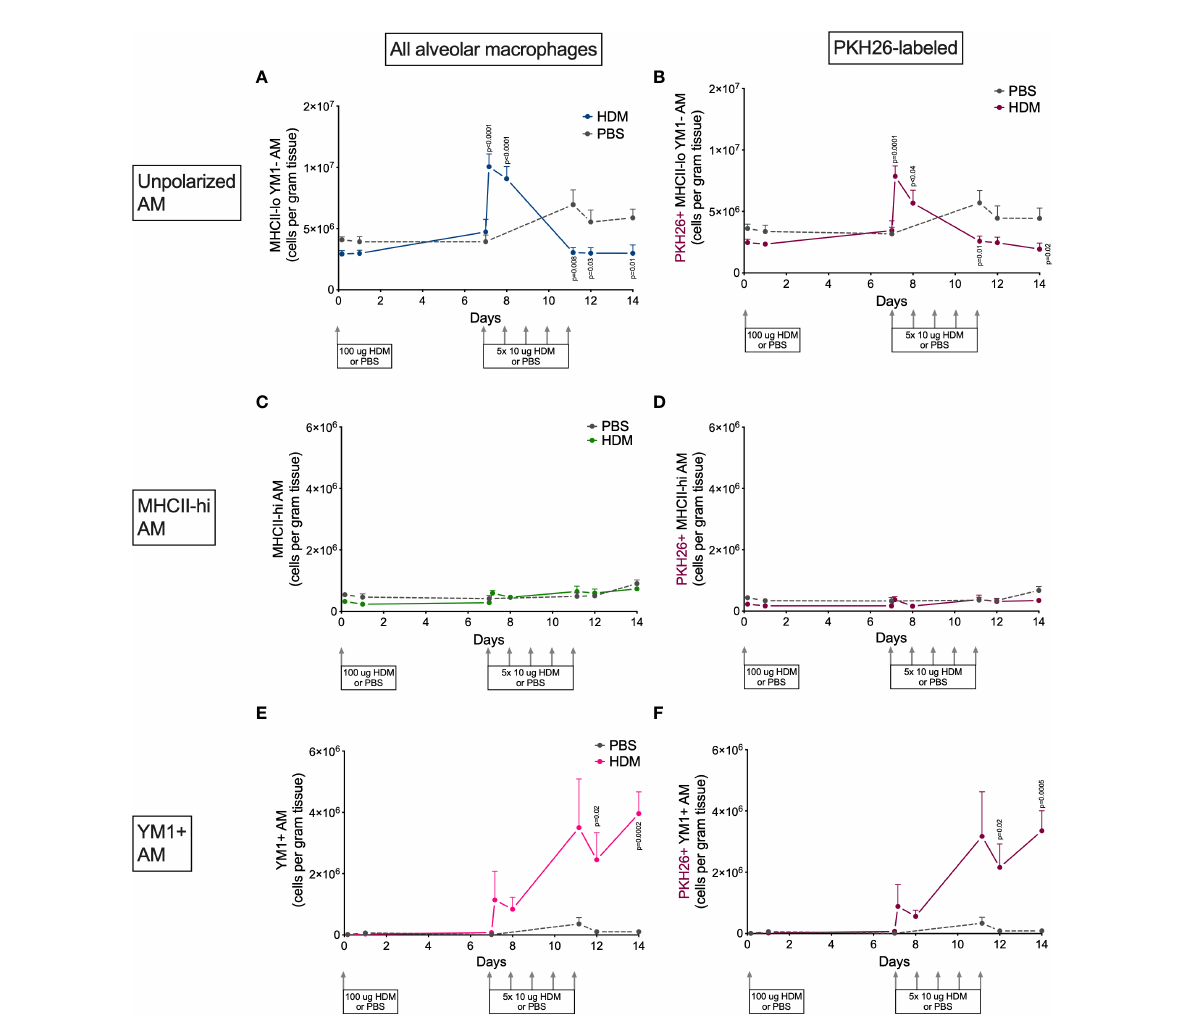
FIGURE 6 Numbers of (A) MHCII-loYM1- alveolar macrophages, (B) PKH26+MHCII-loYM1-alveolar macrophages, (C) MHCII-hi alveolar macrophages, (D) PKH26+MHCII-hi alveolar macrophages, E) YM1+ alveolar macrophages, (F) and PKH26+YM1+ alveolar macrophages in lung tissue of house dust mite (HDM)-exposed and phosphate-buffered saline (PBS)-exposed mice at different time points during exposure. The differences between HDM and PBS per time point were tested using a Student ’ s t test. Day 7.2 and day 8 of HDM were compared to day 7 of PBS with a one-way ANOVA with Sidak ’ s correction for multiple testing because these mice did not have matching PBS-exposed mice. P<0.05 was